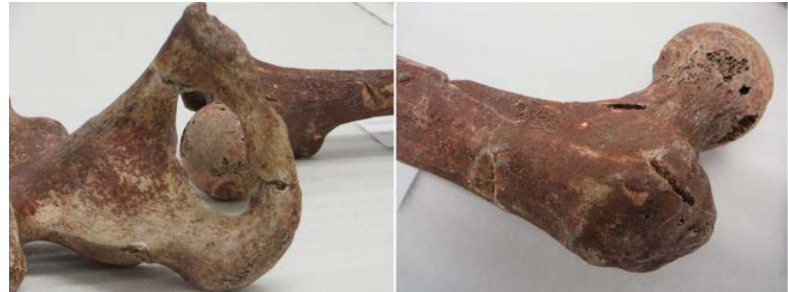
Figure 2. Red ochre encrusting the bones of the Red Lady of Pavilland Cave, a Late Palaeolithic ochre burial. Photograph by Ruth Siddall, reproduced with permission of the Oxford University Museum of Natural History; specimen registration number Q.00001; Image ©OUMNH.